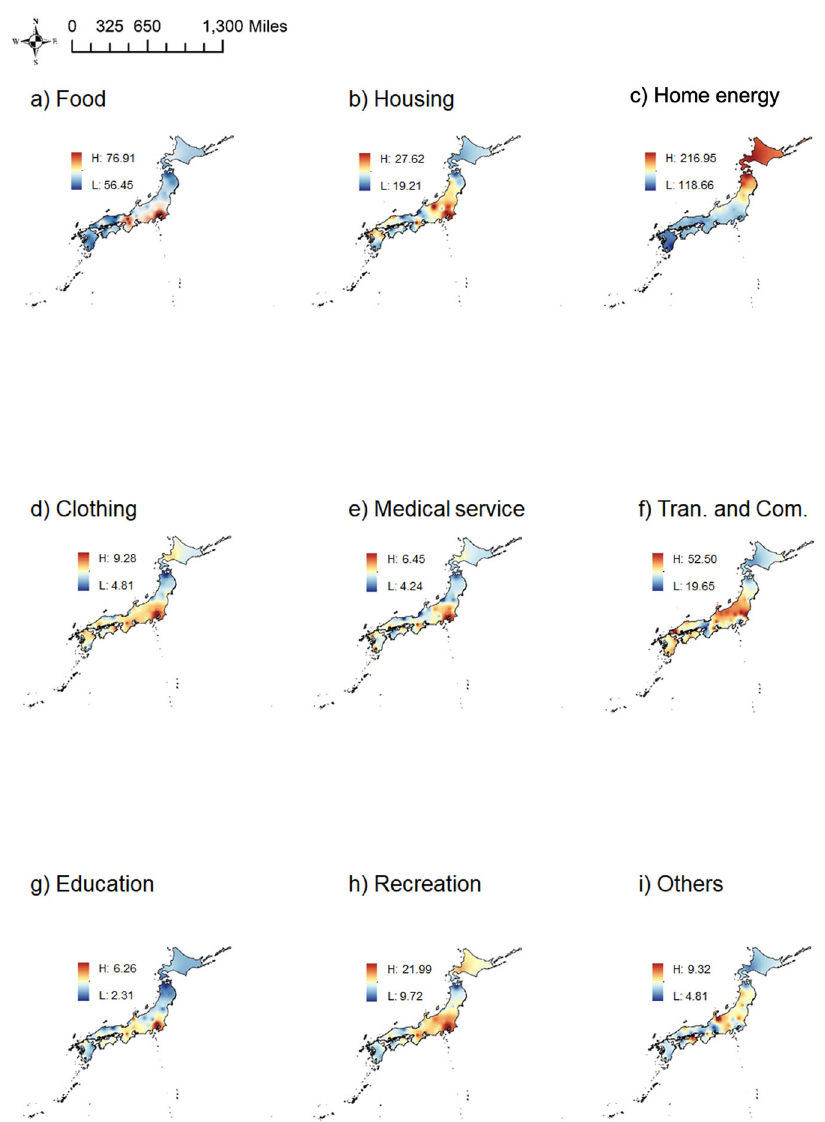
Fig. 3 Distribution of city-level carbon footprints by demand (in kgCO 2 eq/cap/month). The categories of household consumption demand include: a Food, b Housing, c Home energy, d Clothing, e Medical service, f Transportation and Communication, g Education, h Recreation, and i